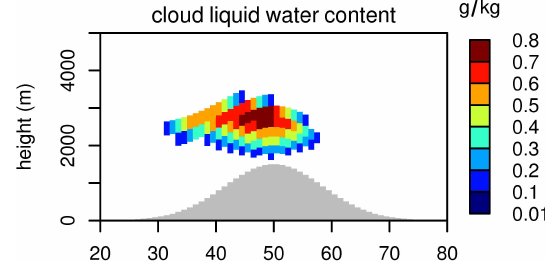
Fig. 1. Cloud liquid water distribution (gkg − 1 ).